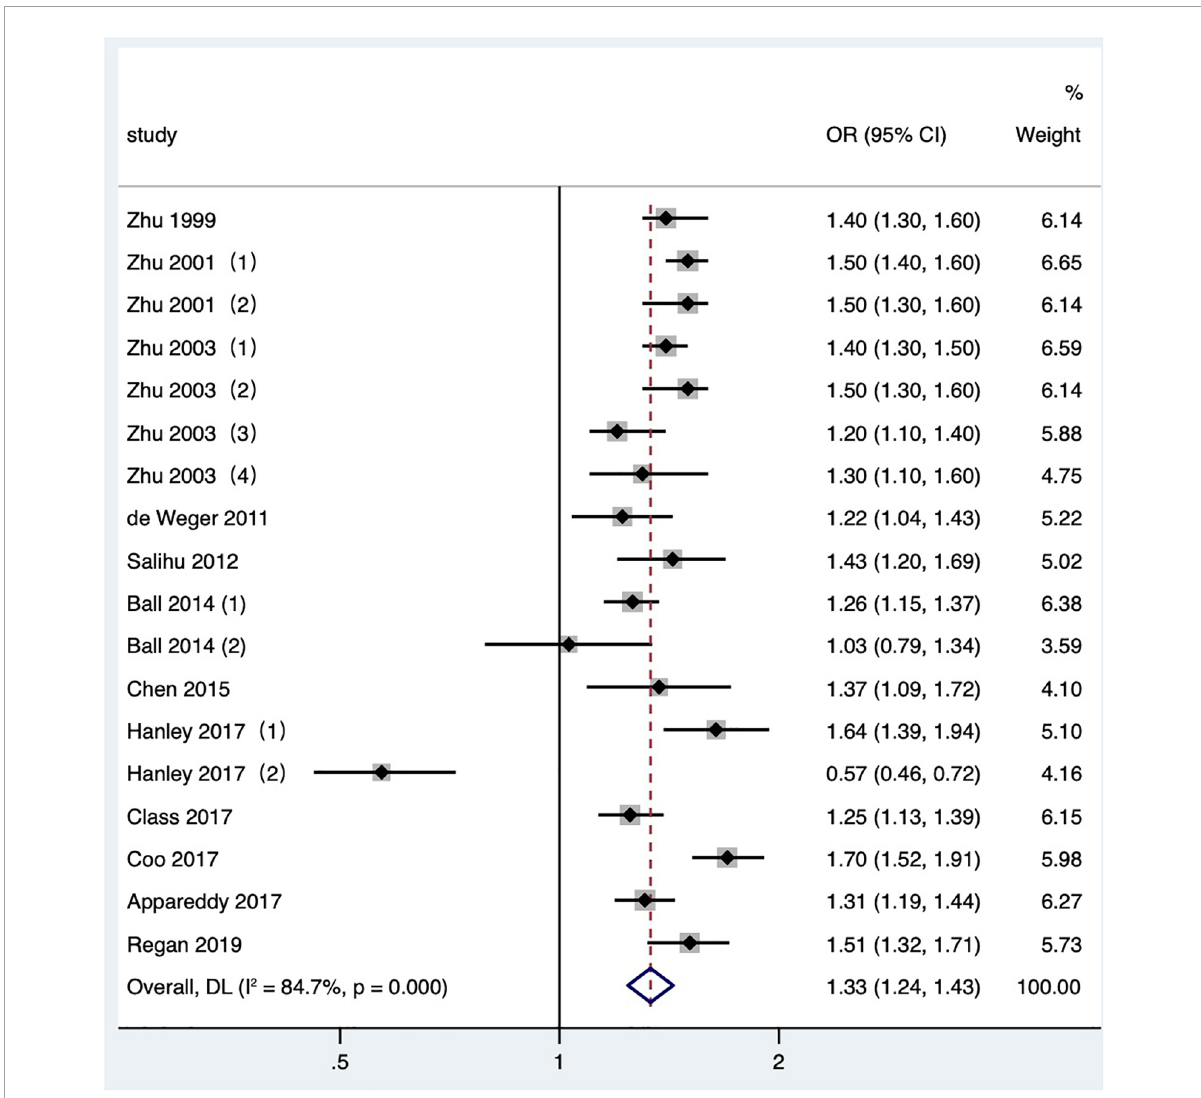
FIGURE4 Meta-analysis forest map of the effect of short IPI on low birth weight. Zhu et al. (15) (1) was white data, Zhu et al. (15) (2) was black data; Zhu and Le (3) (1) studied the IPI between the first pregnancy and the second pregnancy; Zhu and Le (3) (2) studied the IPI between the second and third pregnancy; Zhu and Le (3) (3) studied the IPI between the third and fourth pregnancy; Zhu and Le (3) (4) studied the IPI between the fourth and fifth pregnancy; Ball et al. (24) (1) was non-matching data, Ball et al. (24) (2) was within-mother matching data; Hanley et al. (36) (1) was non-matching data, and Hanley et al. (36) (2) was within-mother matching data.